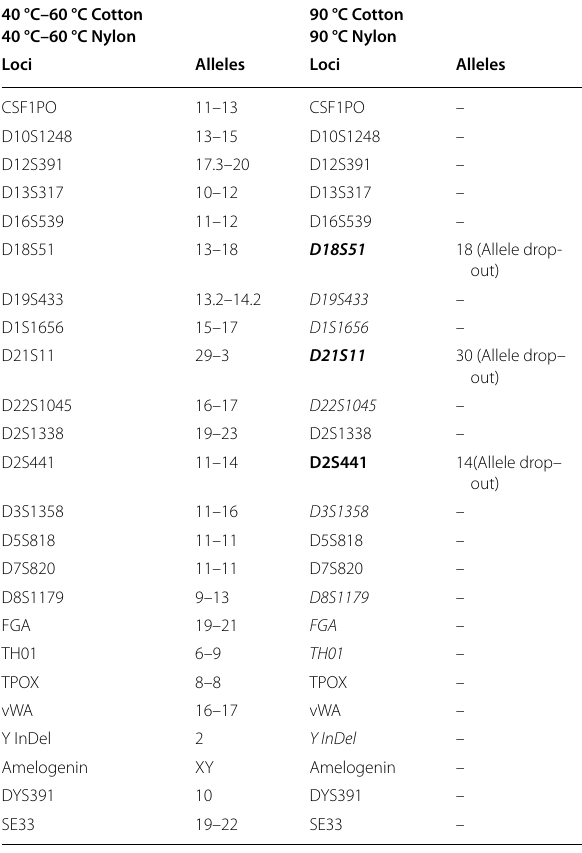
Allelic dropout was observed at bold-marked